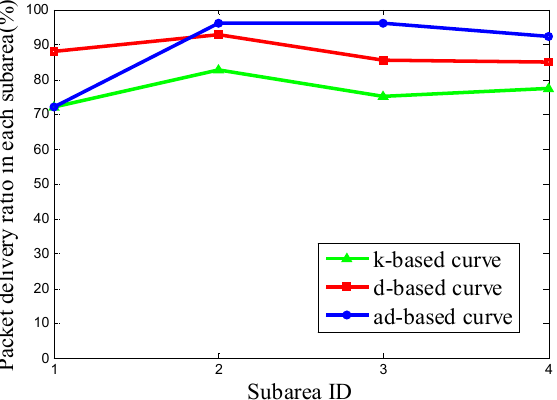
Figure 13. The PDR of k-based, d-based and adjustable d-based curve in node deployment (c) in Scenario 2. Table 4. The overall PDR of k-based, d-based and adjustable d-based curves in Scenario 2.